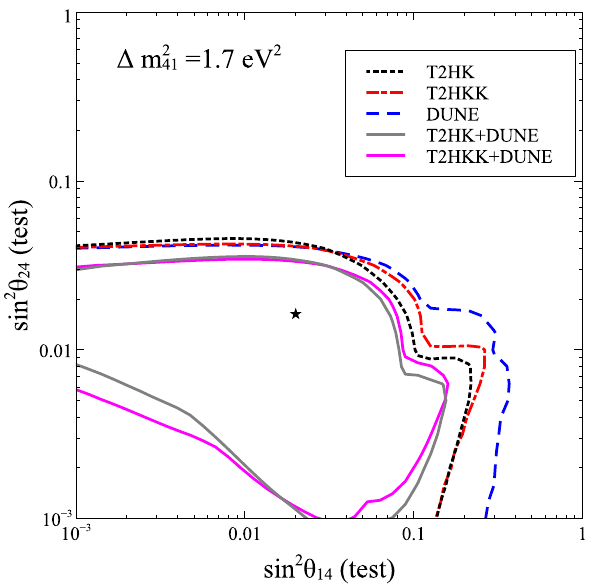
Fig. 6 The expected 95% C.L contours in sin 2 θ 24 (test)-sin 2 θ 14 (test) plane. The colour code is same as Fig.